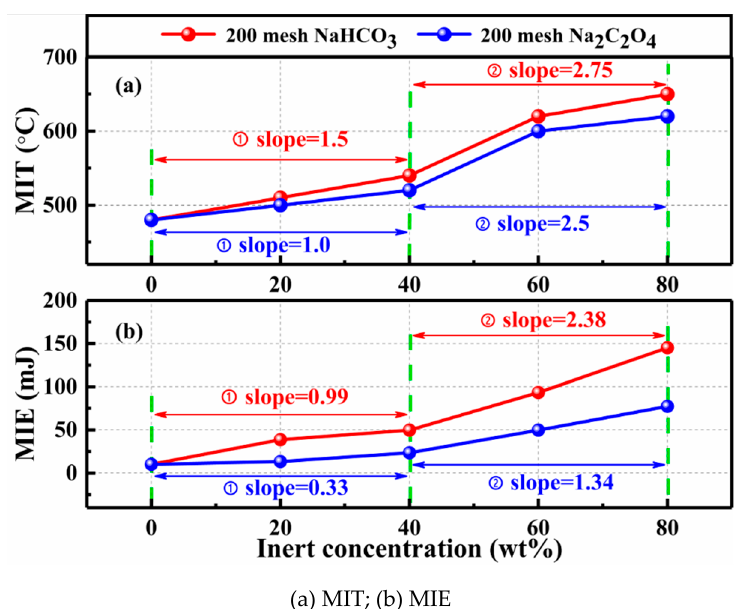
Figure 7. Effect of NaHCO 3 and Na 2 C 2 O 4 powder concentrations on the MIT and MIE of PE. Figure 7. E ff ect of NaHCO 3 and Na 2 C 2 O 4 powder concentrations on the MIT and MIE of PE.